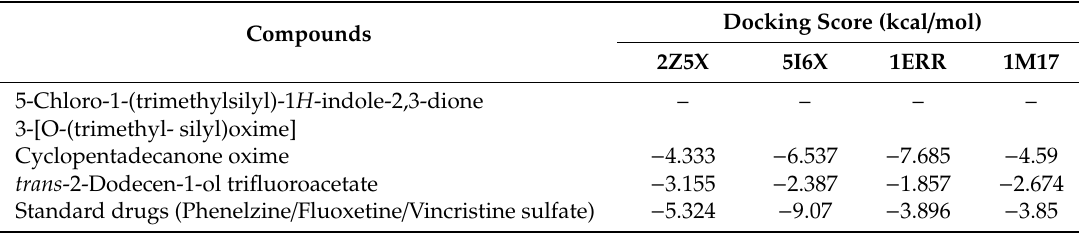
Table 7. Docking scores of the identified compounds from methanol extract of C. pectinata leaves. Docking Score (kcal / mol) Compounds 2Z5X 5I6X 1ERR 1M17 5-Chloro-1-(trimethylsilyl)-1 H -indole-2,3-dione Cyclopentadecanone oxime − 4.333